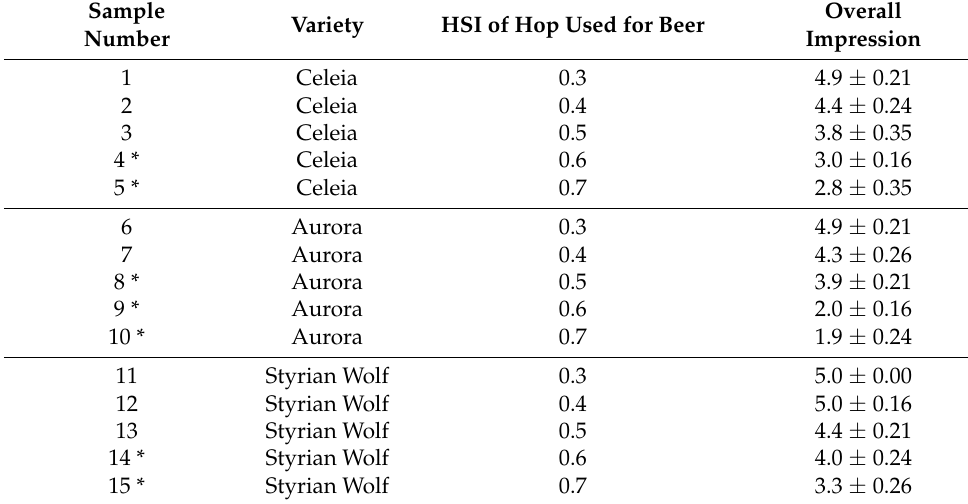
Table 7. Results of sensorial analysis for overall impression, presented as mean value ± standard